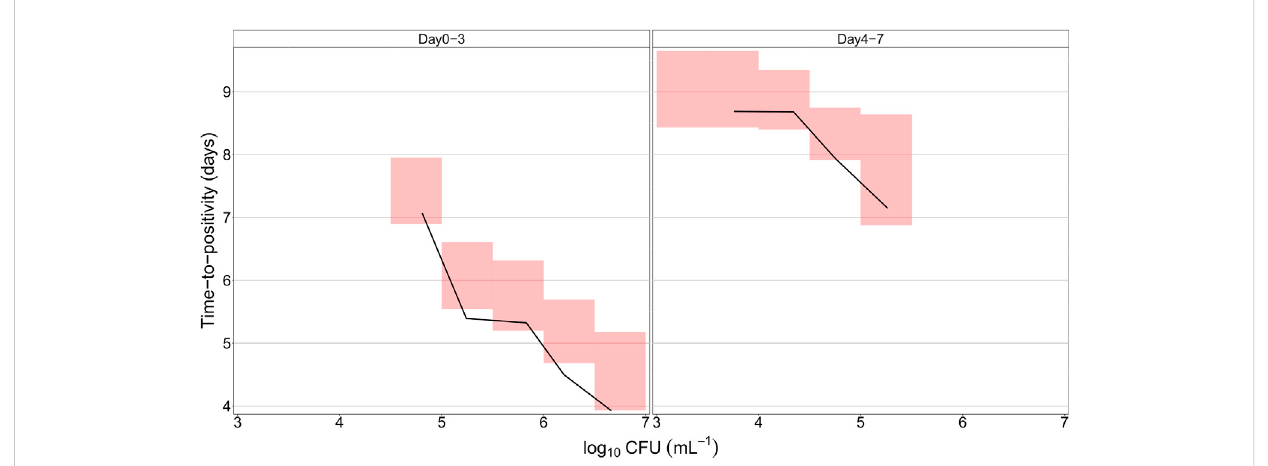
FIGURE 4 Predicted relationship between colony forming unit (CFU) versus time-to-positivity (TTP) using the fi nal quantitative biomarker model. The solid lines represent the median of the observed data, while the shaded areas outline the 95% con fi dence interval based on 1,000 simulations.